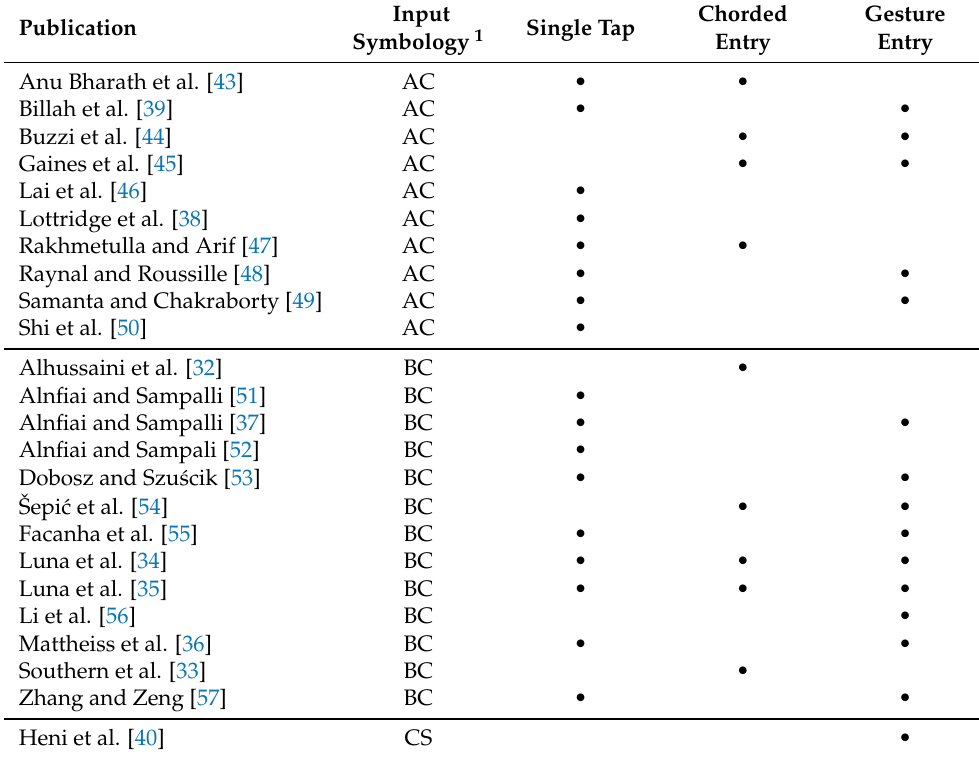
Table 2. Input method